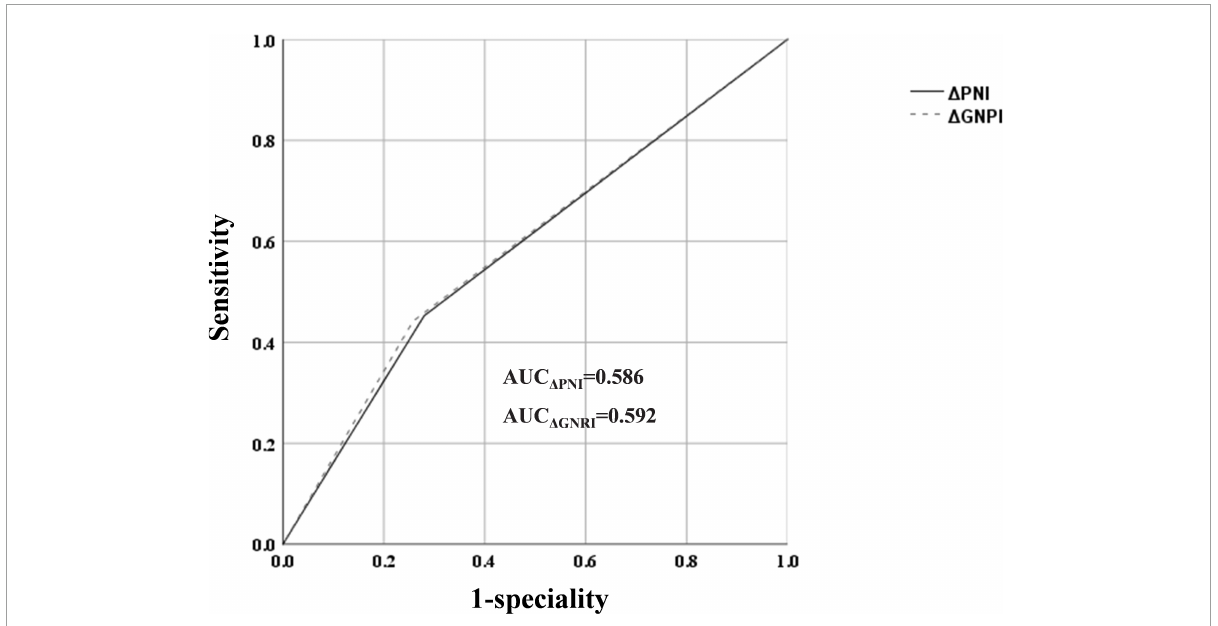
FIGURE4 Receiver operating characteristic (ROC) curve result for (cid:49) PNI and (cid:49)